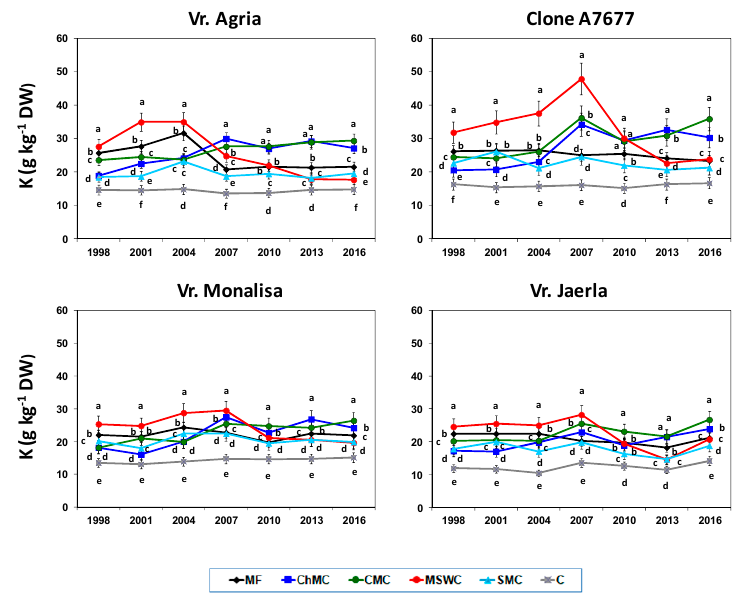
10 of 25 Figure 5. Evolution of the phosphorus content (g kg − 1 DW DW) in potato tubers of the Agria,